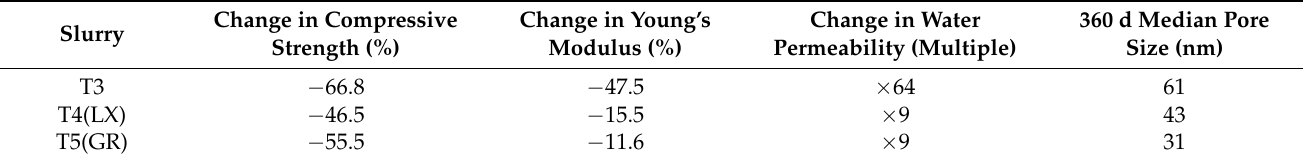
Table 3. Variation of test properties from 2 to 360 d and median pore size of 360 d sample (150